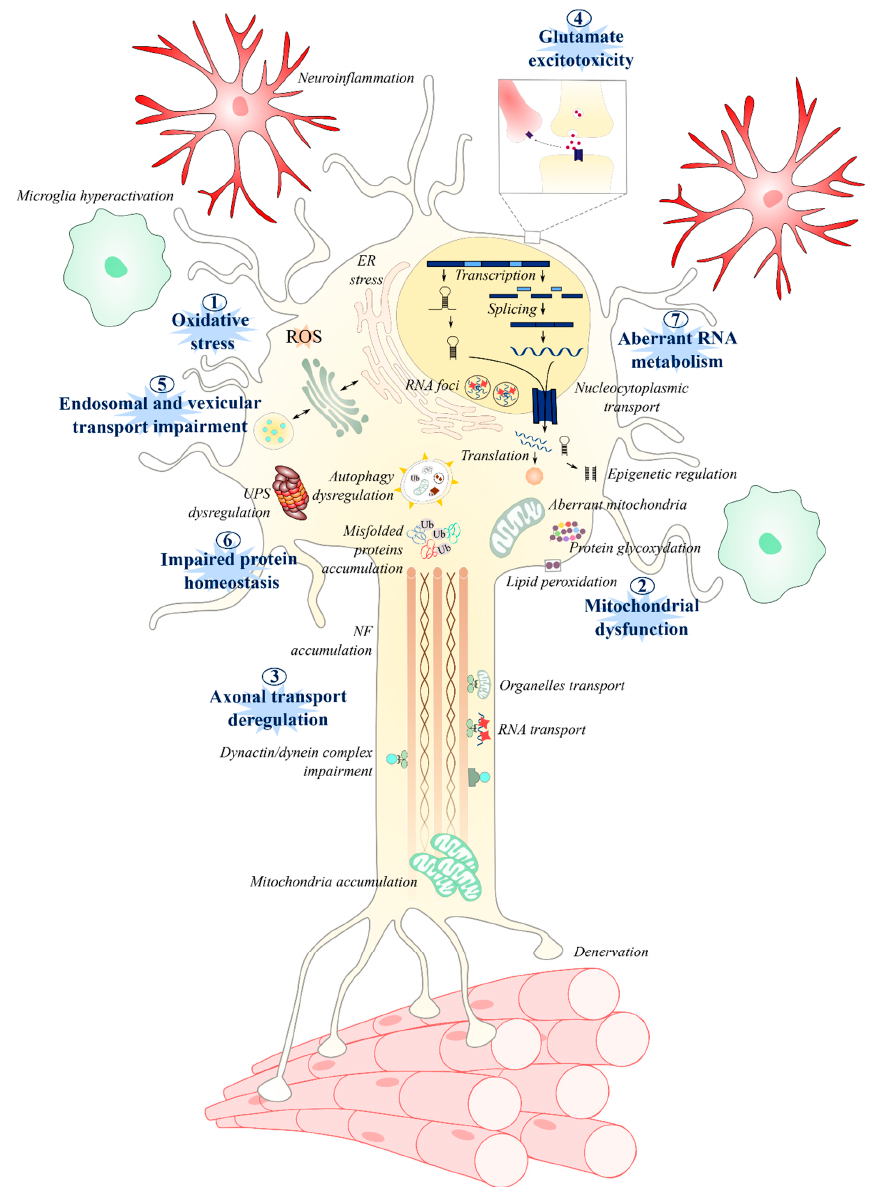
Figure 4. Summary of the different molecular and cellular mechanisms involved in ALS pathogenesis.